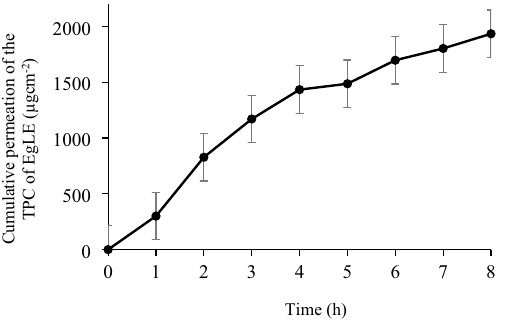
Figure 5. Cumulative amount of TPC of EgLE permeated from the optimal nanoemulsion after 8 h.